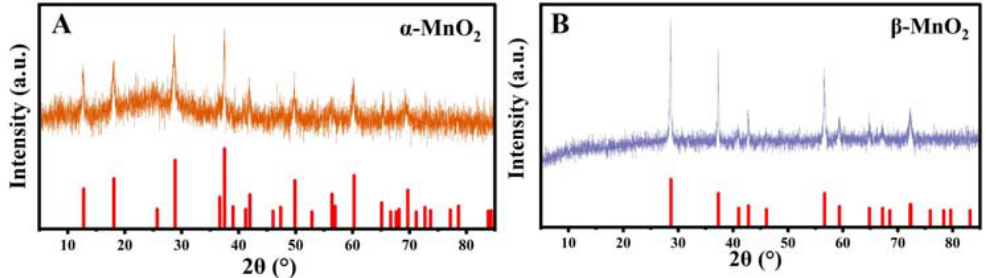
Figure 1. XRD patterns of α -MnO 2 ( A ) and β -MnO 2 ( B ).